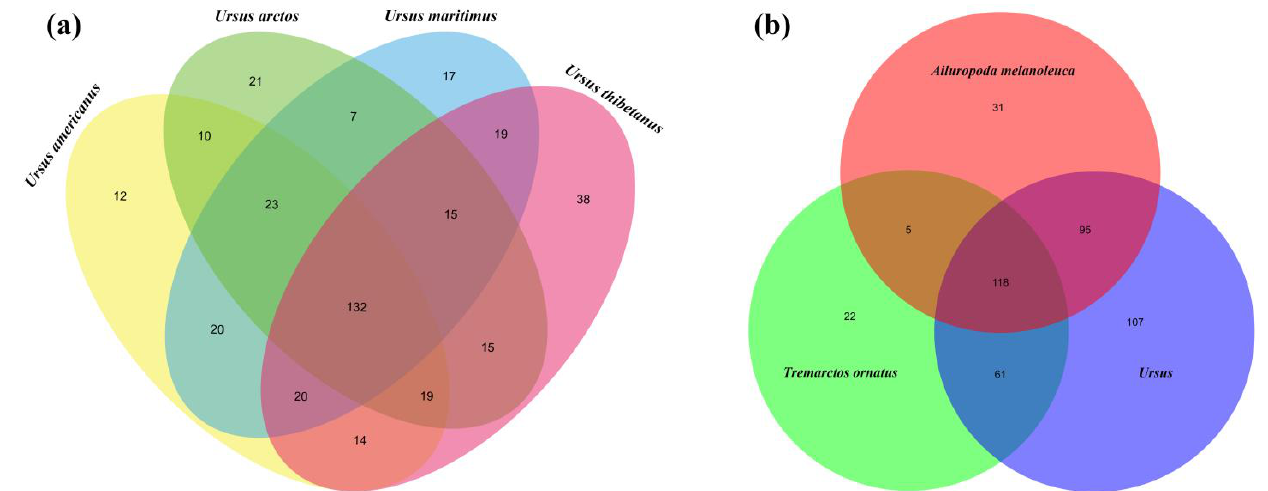
Figure 5. Comparison of OR gene clusters ( a ) between four species from genus Ursus ( b ) between three different genera from family Ursidae.